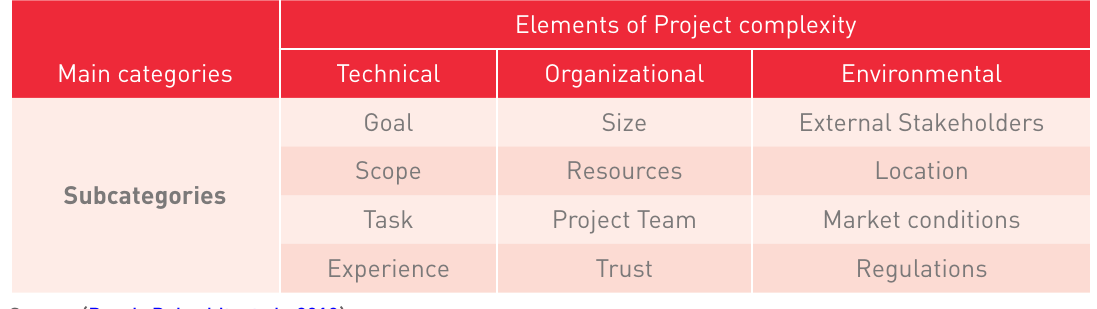
TOE framework for project